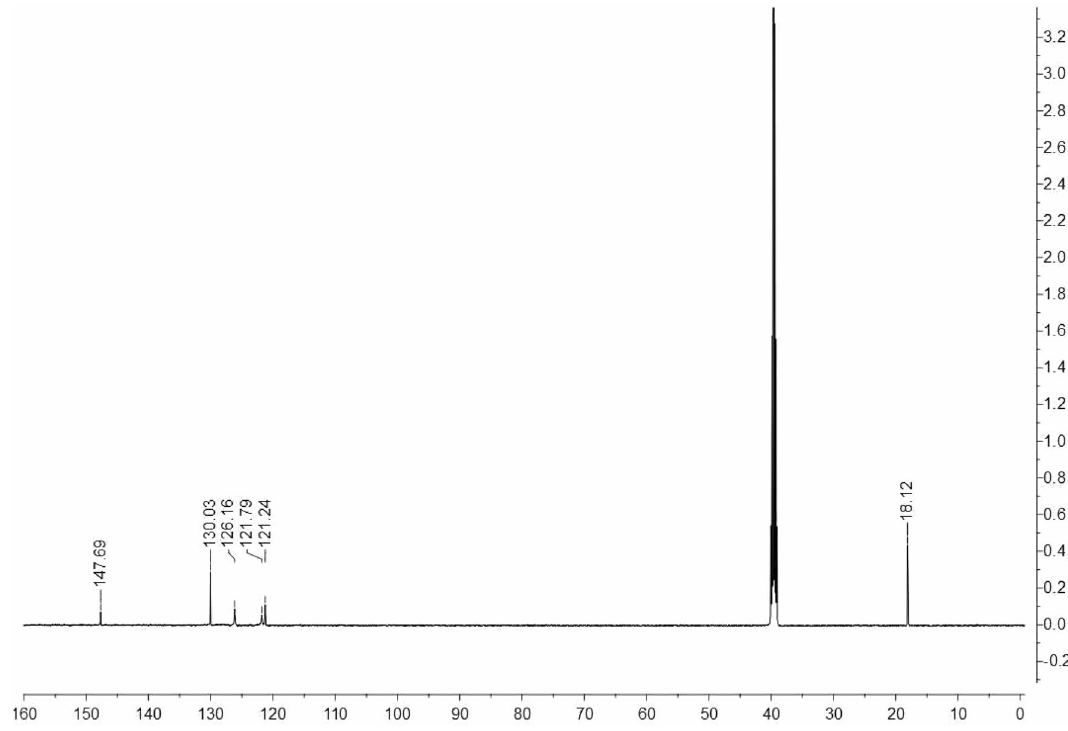
Figure 4. 13 C NMR spectrum of the DTG inhibitor in DMSO- d 6 .